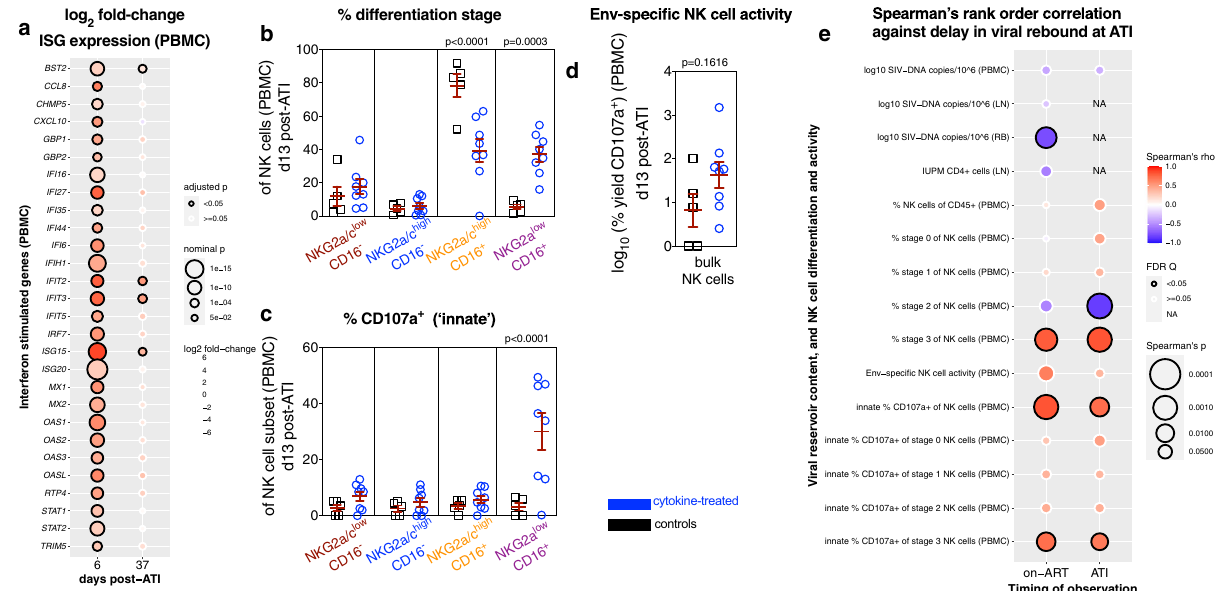
Fig. 5 The formation and activity of NKG2a low CD16 + NK cells correlate with viral recrudescence following ATI. a From PBMCs taken 24 h following the fi rst (d6 post ATI) and the fi fth PEG-IFN α dose (d37 post ATI), the expression of interferon-stimulated genes was calculated as a cross-sectional log 2 fold- change between cytokine-treated ( n = 8) and control ( n = 5) RMs, which is represented as a double-gradient heatmap. The size of each data point corresponds inversely to the log 10 -transformed nominal p value with signi fi cant ( p < 0.05) adjusted p values indicated by a black border. Using DESeq2, data were analyzed with a two-sided (95% CI) Wald test using the Benjamini – Hochberg method for multiple comparisons. b In PBMCs at d13 post ATI, the distribution of the differentiation subsets was measured by fl ow cytometry as a frequency of NK cells: Stage 0 (red, NKG2a/c low CD16 – ), Stage 1 (blue, NKG2a/c high CD16 – ), Stage 2 (orange, NKG2a/c high CD16 + ), and Stage 3 (purple, NKG2a/c low CD16 + ). NK cells isolated from PBMCs at d13 post ATI were utilized to determine c the frequency of ex vivo innate activity (CD107a surface expression) or d the Env-speci fi c activity upon co-culture with K562 cells expressing HLA-E loaded with SIVmac Env peptides. b – d Data from individual cytokine-treated (PEG-IFN α with prior ART + IL-21 + rIFN α , blue; n = 8) and control (prior ART-only, black; n = 5) RMs (open symbols) are overlaid against the mean ± SEM (in red) and were analyzed with b , c two-sided (95% CI), two-way ANOVA with Bonferroni ’ s correction for cross-sectional comparisons relative to controls or d with a two-sided (95% CI) Mann – Whitney U test. e The delay in the rebound of plasma viremia was correlated against measures of SIV content, NK cell differentiation, and NK cell activity (as indicated at left; n = 13) from the fi nal on-ART measurement (d339 – 374 p.i.) or during rebound following ATI (d6 – 13 post ATI). Per each correlation the two-tailed (95% CI) Spearman ’ s rank correlation coef fi cient (rho) is represented as a double-gradient heatmap and the size of each data point corresponds inversely to the log 10 -transformed Spearman ’ s p value. The false discovery rates (FDR) were calculated using SAS and signi fi cant values ( Q < 0.05) are represented by a black border. Correlations for which data did not exist during that experimental phase are indicated as “ NA ” . were segmented using a sterile scalpel; macerated over RPMI 1640 medium sup- with a Cyto fi x/Cytoperm kit (BD Biosciences). Flow cytometry acquisition was per- plemented with 10% heat-inactivated fetal bovine serum (FBS; Gemini Bio), 100 U/ formed on a minimum of 120,000 live CD3 + T cells for PBMC and LN, and a mL penicillin, and 100 μ g/mL streptomycin; and fi ltered through a 100- μ m strainer minimum of 50,000 live CD3 + T cells in RB. Data acquisition was performed on an to isolate mononuclear cells. Tissue segments of LN and 2 – 4 RB punches were fl ash LSR II (BD Biosciences) using FACS DiVa software (v8.0.1) and analyzed using frozen in dry ice for SIV-DNA analysis, whereas processed mononuclear cells were FlowJo software (version 9.9.6; TreeStar). Gates for activation (HLA-DR + CD38 + ) cryo-preserved in 10% dimethyl sulfoxide (DMSO) in FBS. and proliferation in memory CD4 + T cells and memory CD8 + T cells were set based on their expression within the corresponding naive subset. Cryo-preserved PBMCs were stained as previously described 37 to characterize NK Flow cytometric analysis . Fourteen-parameter fl ow cytometric analysis was per- cell subsets using a panel of the following mAbs: anti-CD3-V500 (clone SP34-2, 5 μ L, cat. 560770), anti-CD45-PerCP (clone D058-1283, 5 μ L, cat. 558411), and anti-CD69- formed on fresh PBMCs and mononuclear cells derived from LN biopsies and RB punches. Samples were stained utilizing standard procedures employing clones of anti-human mAbs that we have shown to be cross-reactive in RMs 20,44,46,47 and are validated in databases maintained by NHP Reagent Resource (MassBiologics: https:// www.nhpreagents.org/ReactivityDatabase). The following antibodies were utilized for the longitudinal staining panel per T-cell and B-cell characterization: anti-CD21-PE (clone B-ly4, 10 μ L, cat. 555422), anti-CD28-PE-CF594 (clone CD28.2, 5 μ L, cat. 562296), anti-CD95-PE-Cy5 (clone DX2, 10 μ L, cat. 559773), anti-CCR7-PE-Cy7 (clone 3D12, 7.5 μ L, cat. 557648), anti-CD45RA-APC (clone 5H9, 10 μ L, cat. 561210), anti-Ki-67-AL700 (clone B56, 5 μ L, cat. 561277), and anti-CD3-APC-Cy7 (clone SP34-2, 5 μ L, cat. 557757) all from BD Biosciences; anti-HLA-DR-BV570 (clone L243, 5 μ L, cat. 307638), anti-CD27-BV605 (clone O323, 10 μ L, cat. 302830), anti-CD20- PerCP-Cy5.5 (clone 2H7, 5 μ L, cat. 302326), and anti-CD4-BV421 (clone OKT4, 2.5 μ L, cat. 317438) all from BioLegend; anti-CD38-FITC (clone AT-1, 5 μ L, cat. 60131FI) from STEMCELL Technologies; and anti-CD8-Qdot705 (clone 3B5, 1 μ L, cat. Q10059) and Live/Dead Fixable Aqua (AmCyan, 2 μ L of 1:20 PBS dilution, cat. L34957) from Thermo Fisher Scienti fi c (Supplementary Fig. 1a). A secondary panel using a similar parental gating strategy, with the exception of using anti-CD4-BV605 (clone OKT4, 5 μ L, cat. 317438 from BioLegend), was utilized to measure markers of Representative gating strategies are given in Supplementary Fig. 1b, c and representative cytotoxicity, such as anti-T-bet-PE (clone eBio4B10, 5 μ L, cat. 12-5825-82 from CD107a stains are given in Supplementary Fig. 6d – f. The anti-NKG2a mAb recognizes eBioscience; Supplementary Fig. 1d). Stain volumes are given per 10 6 live mono- both NKG2a and NKG2c in macaques. Stain volumes are given per 10 6 live nuclear cells or per 4 – 5 processed RB punches. Cells were fi xed and permeabilized NATURE COMMUNICATIONS| (2021) 12:2866